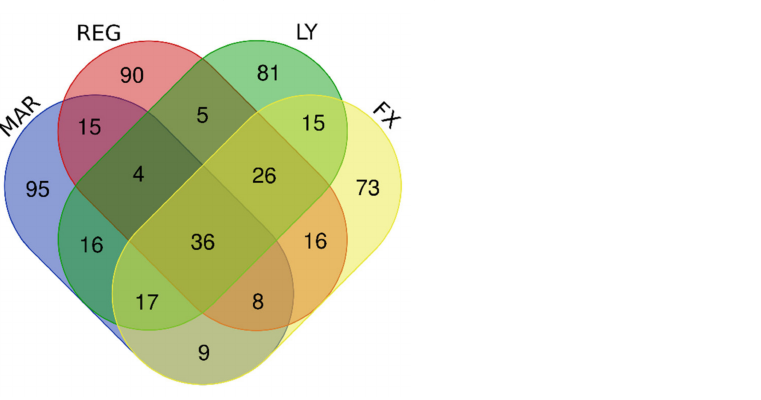
Figure 3. Four-way Venn diagram showing an analysis of the 200 genes with most lowered expression levels in U87MG cells treated with Mardepodect (MAR), Regorafenib (REG), LY-294002 (LY), and Fucoxanthin